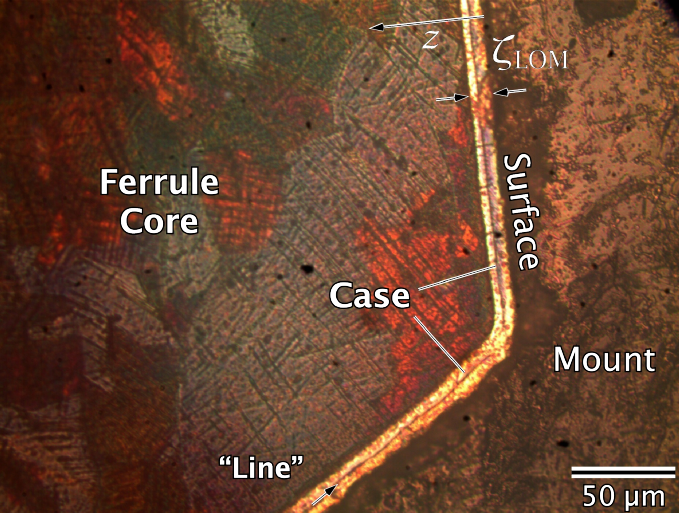
Figure 4. Light-optical micrograph of a color-etched cross-section of a nitrocarburized AISI-316L ferrule.